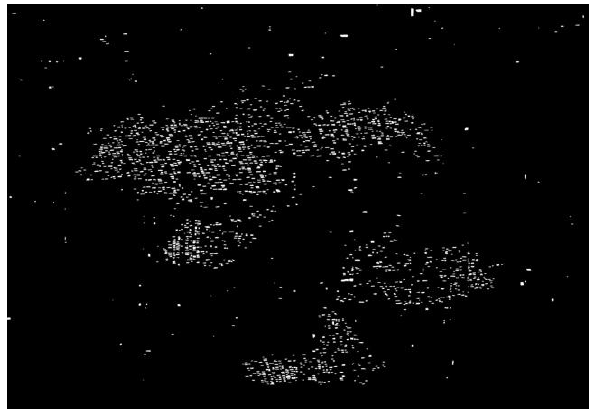
Figure 7. Building footprint detection result in